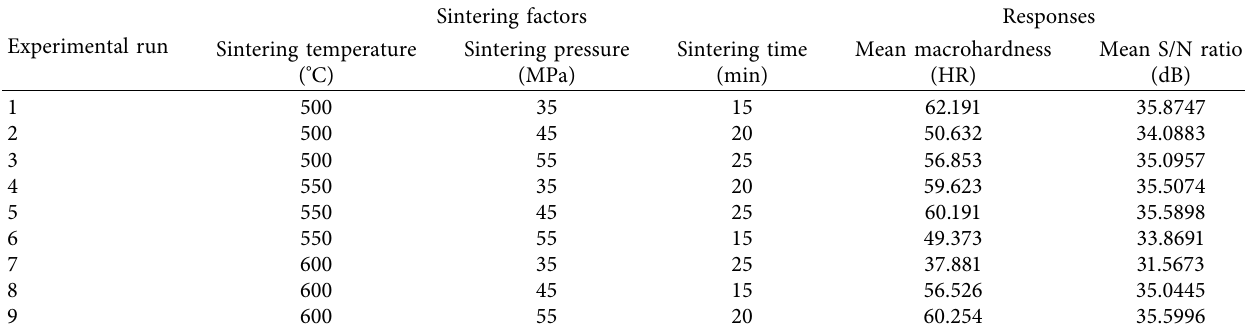
Table 5: Results of experiments sorted by sintering variables for mean macrohardness and signal-to-noise.